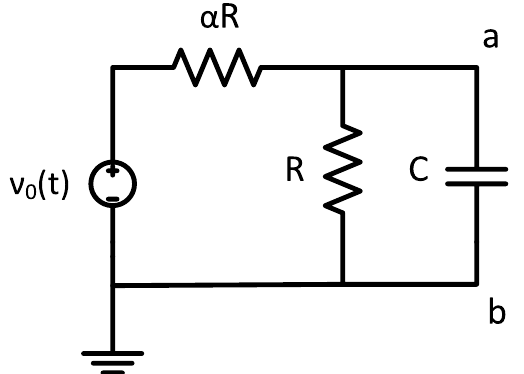
Figure 3. The seed tile for the acTAM consists of a voltage source ν 0 ( t ) , two resistors, R and α R , and a capacitor C . The top node has glue a , and bottom node has glue b